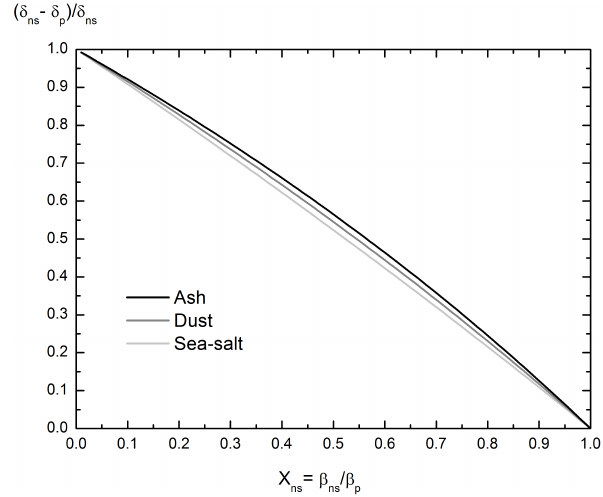
Fig. 5. Systematic bias on δ ns when assuming δ p equals to δ ns for δ ns =10% as for sea-salt particles (light gray), δ ns =20%, as for desert dust particles (dark gray), δ ns =30%, as for volcanic ash (black). This graph allows to measure the need for distinguishing δ p from δ ns